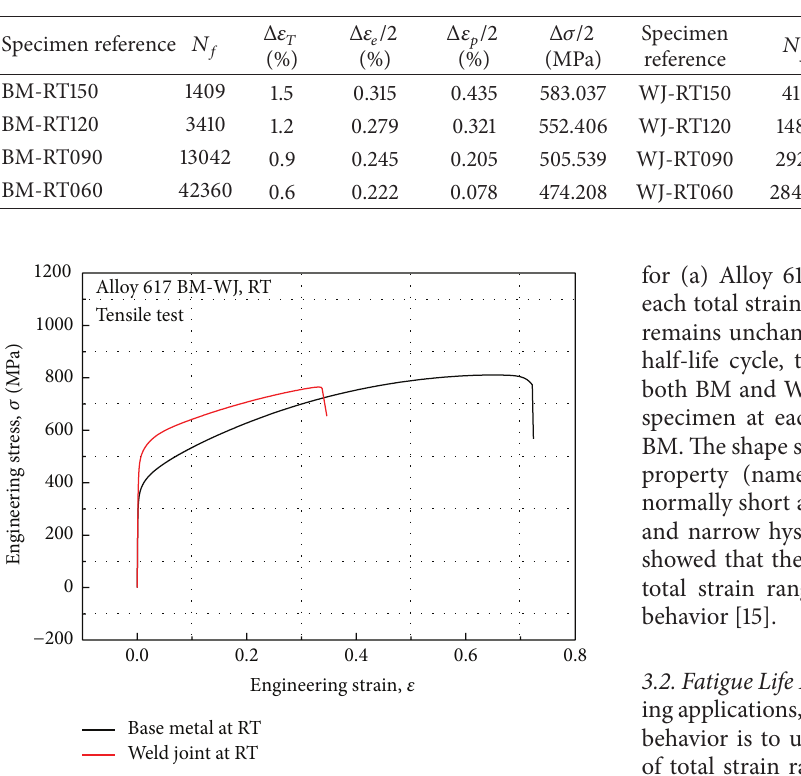
Table 3: The experimental results of LCF for Alloy 617 BM and Alloy 617 WJ.